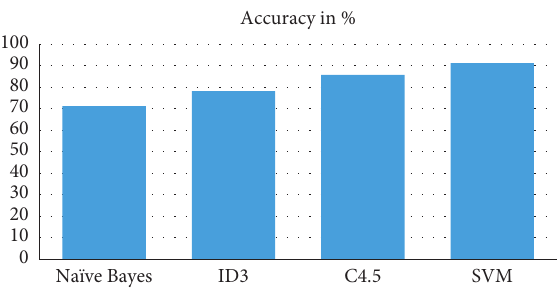
Figure 3: Accuracy results of classification algorithms. Table 3: Results of classification algorithms’ error rate.